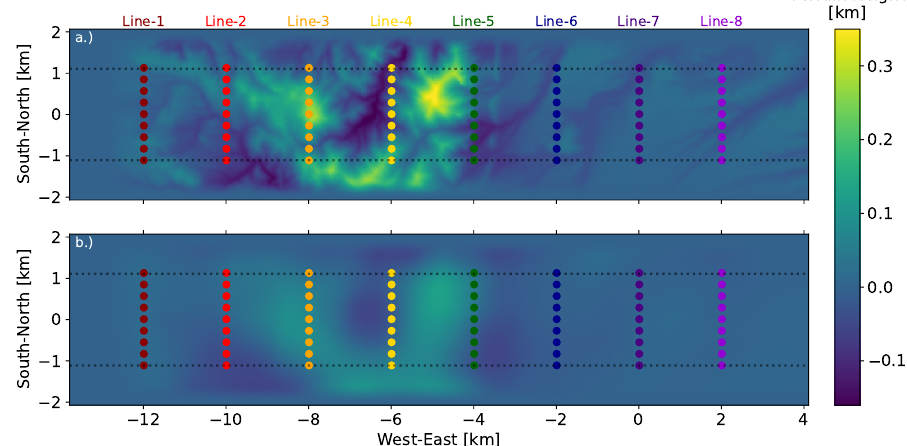
Figure 2. Terrain height for ( a ) the SRTM data and ( b ) smoothed, convolution-filtered data with a 1830 m window with locations of the Tower Lines in colored dots. Dotted black lines denote the analysis domain over which averages are